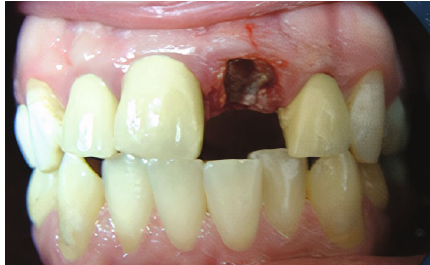
Figure 13: Frontal view of incisor teeth.